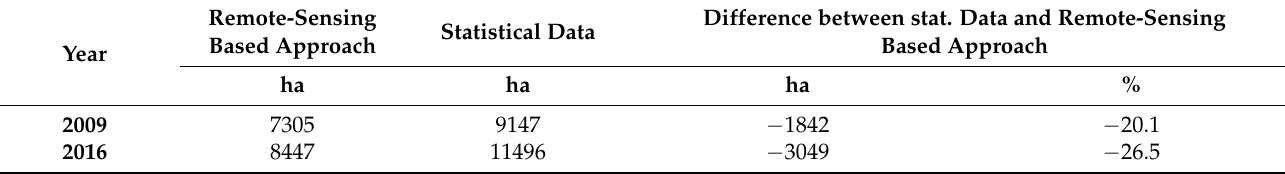
Table 4. Results of the silage maize classification approach using remote-sensing data compared to statistical data. Remote-Sensing Difference between stat. Data and Remote-Sensing Statistical Data Based Approach Based Approach Year ha ha ha